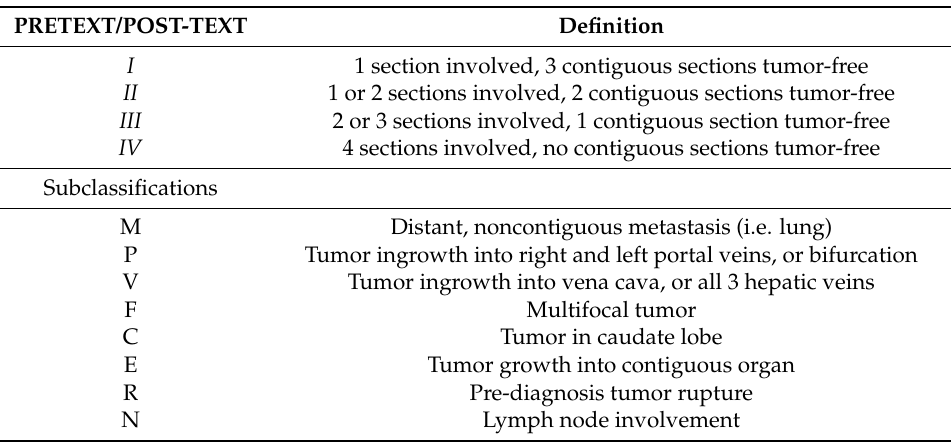
Figure 1. Liver sections [4]. The liver has four sections, separated by the hepatic and portal veins: ( a ) right posterior, ( b ) right anterior, ( c ) left medial, and ( d ) left lateral. Note that the caudate lobe is not considered part of these sections. Table 1. The pre-treatment and post-treatment extent of disease (PRETEXT)/POST-TEXT classification. This classification is used for defining tumors before and after treatment.